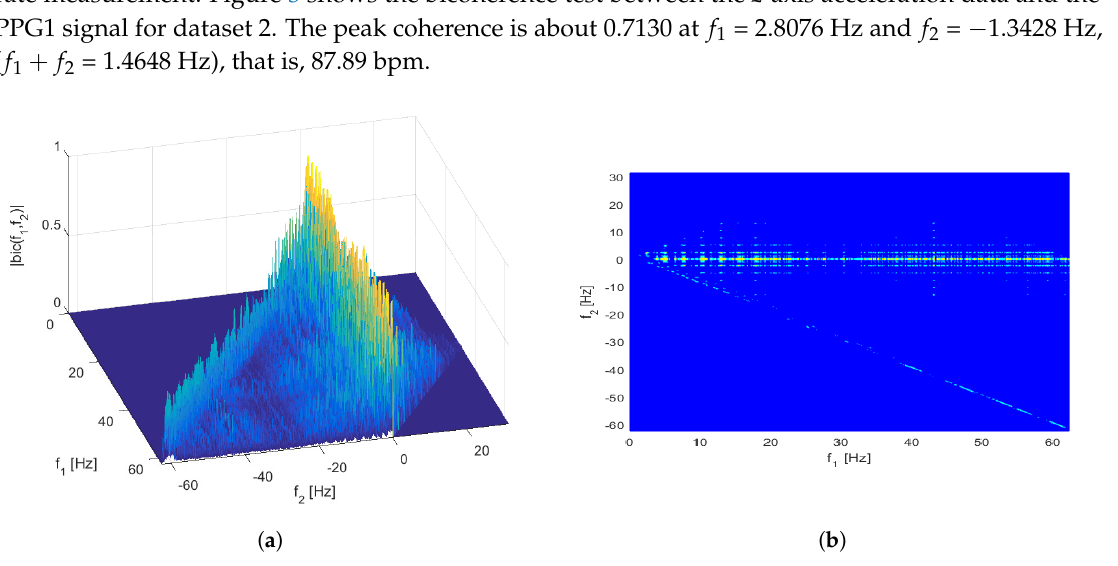
Figure 2. Mesh ( a ) and contour ( b ) plots of the cross bicoherence between PPG1 signal and y -axis acceleration data for dataset 10.